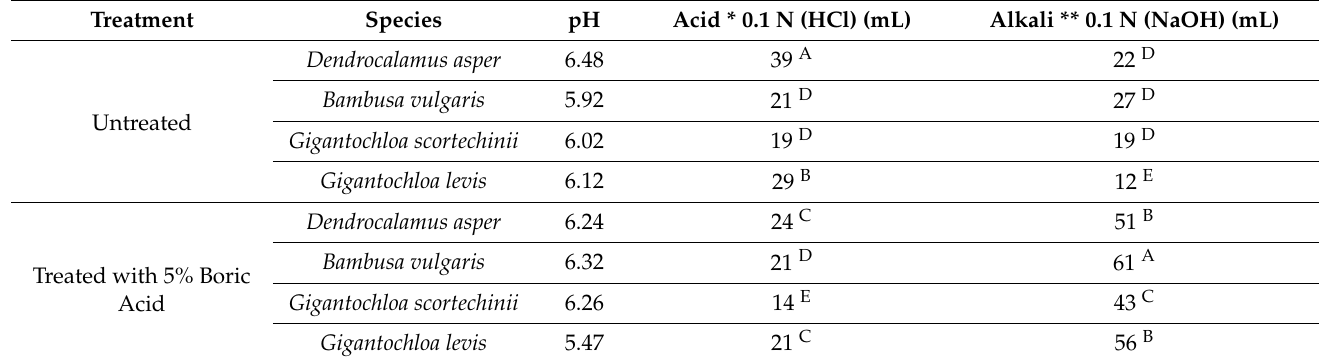
Table 6. The pH and buffering capacity values of untreated and treated strips from four bamboo species.